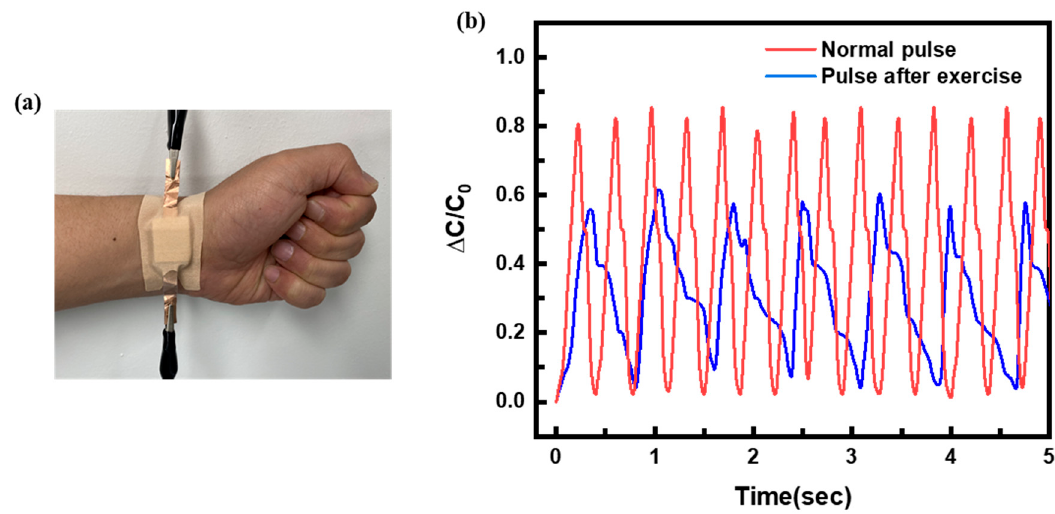
Figure 6. Practical wrist pulse wave applications using a pressure sensor. ( a ) Image of wrist pulse wave measurement of the actual pressure sensor. ( b ) blue indicating the normal pulse and red indicating the pulse after five minutes of exercise.